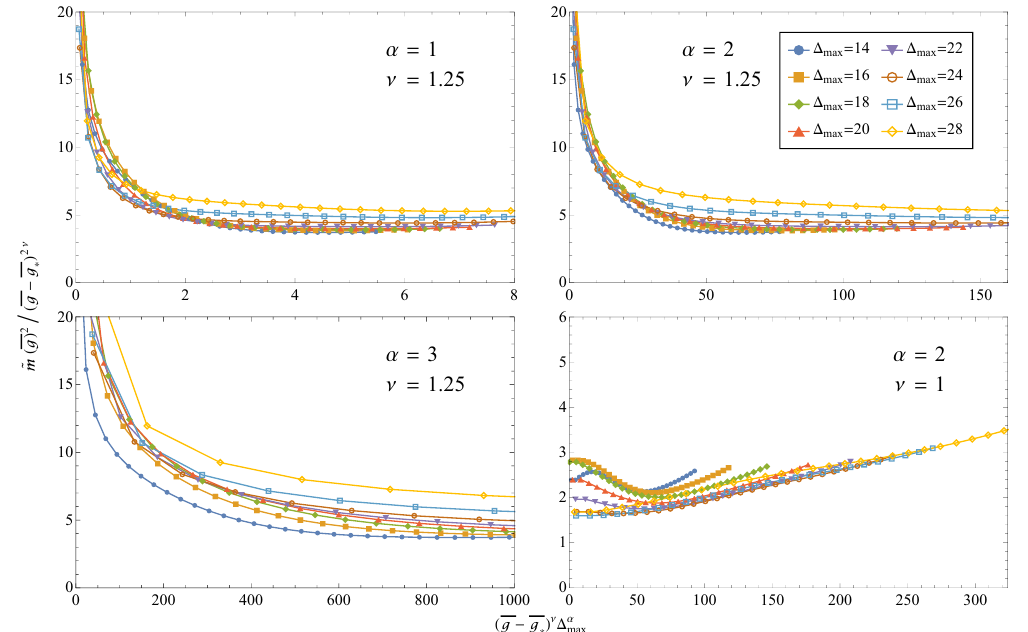
Figure 17 . Testing the universal IR scale model with different parameters. Fixing the critical exponent at the theoretical value, we plot the function with parameter α = 1 (upper left), α = 2 (upper right) and α = 3 (lower left). Compared with α = 2, α = 1 has moderately less universal behavior across different ∆ max in the IR region (small x -axis), while α = 3 clearly does not have universality. Fixing the parameter α = 2 we also consider a different critical exponent, ν = 1 (lower right). Compared with ν = 1 . 25, there is no universal IR behavior in the small x -axis region and the ratio is also not constant above the IR scale (large x